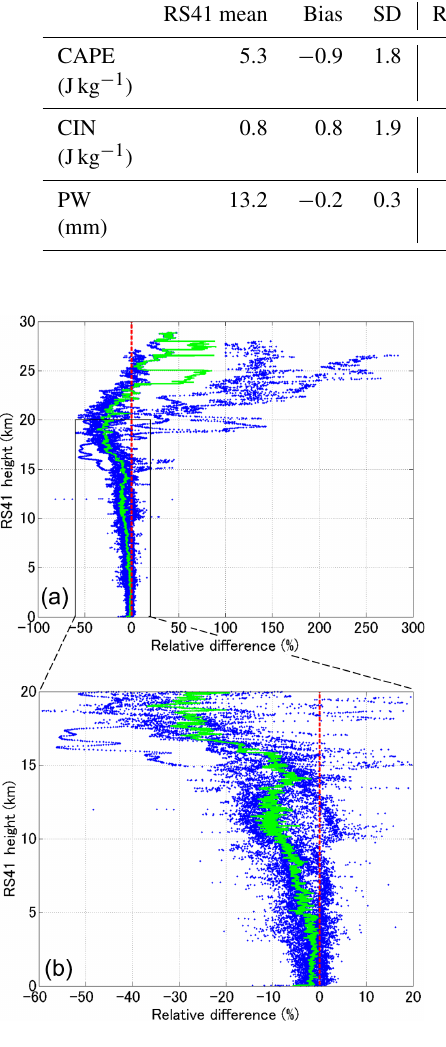
Figure 9. Relative difference between the RS92 and RS41 relative humidity obtained during the daytime on the MR15-04 cruise (blue dots, %). Relative difference is defined as the relative humidity dif- ference expressed as a percentage of the RS41 relative humidity. Green line denotes the median of the relative difference. (b) shows an enlargement of part (a) .